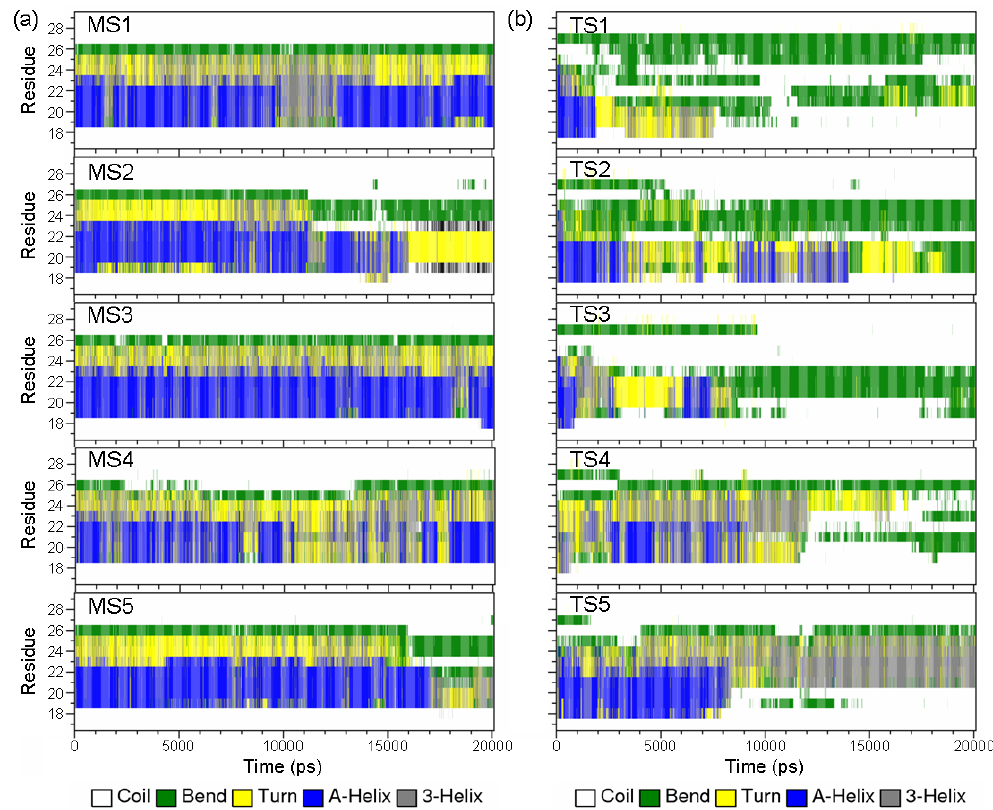
Figure S2. Secondary structure analysis of p53N from p53N-MDM2 ( a ) and p53-Taz2 ( b ) during simulations. Simulations MS1–MS5 and TS1–TS5 are presented.